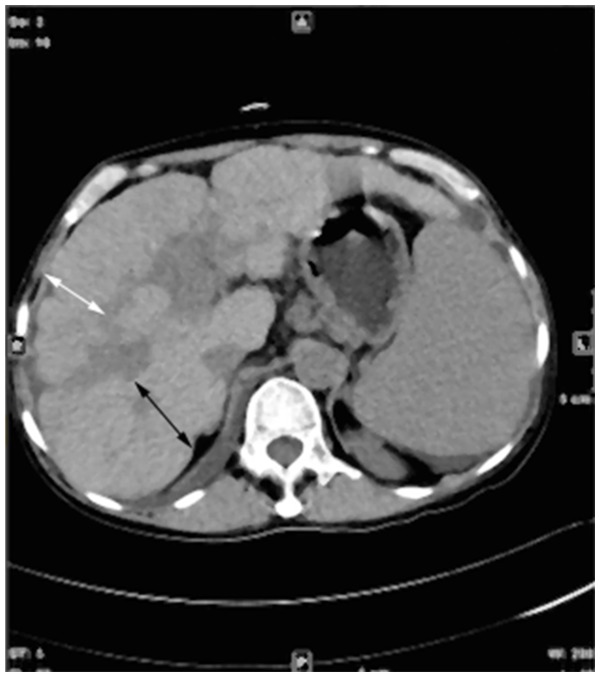
Cirrhotic morphology in CT imaging.Portal venous phase CT scan shows nodularity on the liver surface and heterogeneity of the liver parenchyma. A ratio of transverse caudate lobe width (black arrow) to right lobe width (white arrow) is greater than 0.65. Splenomegaly was present.